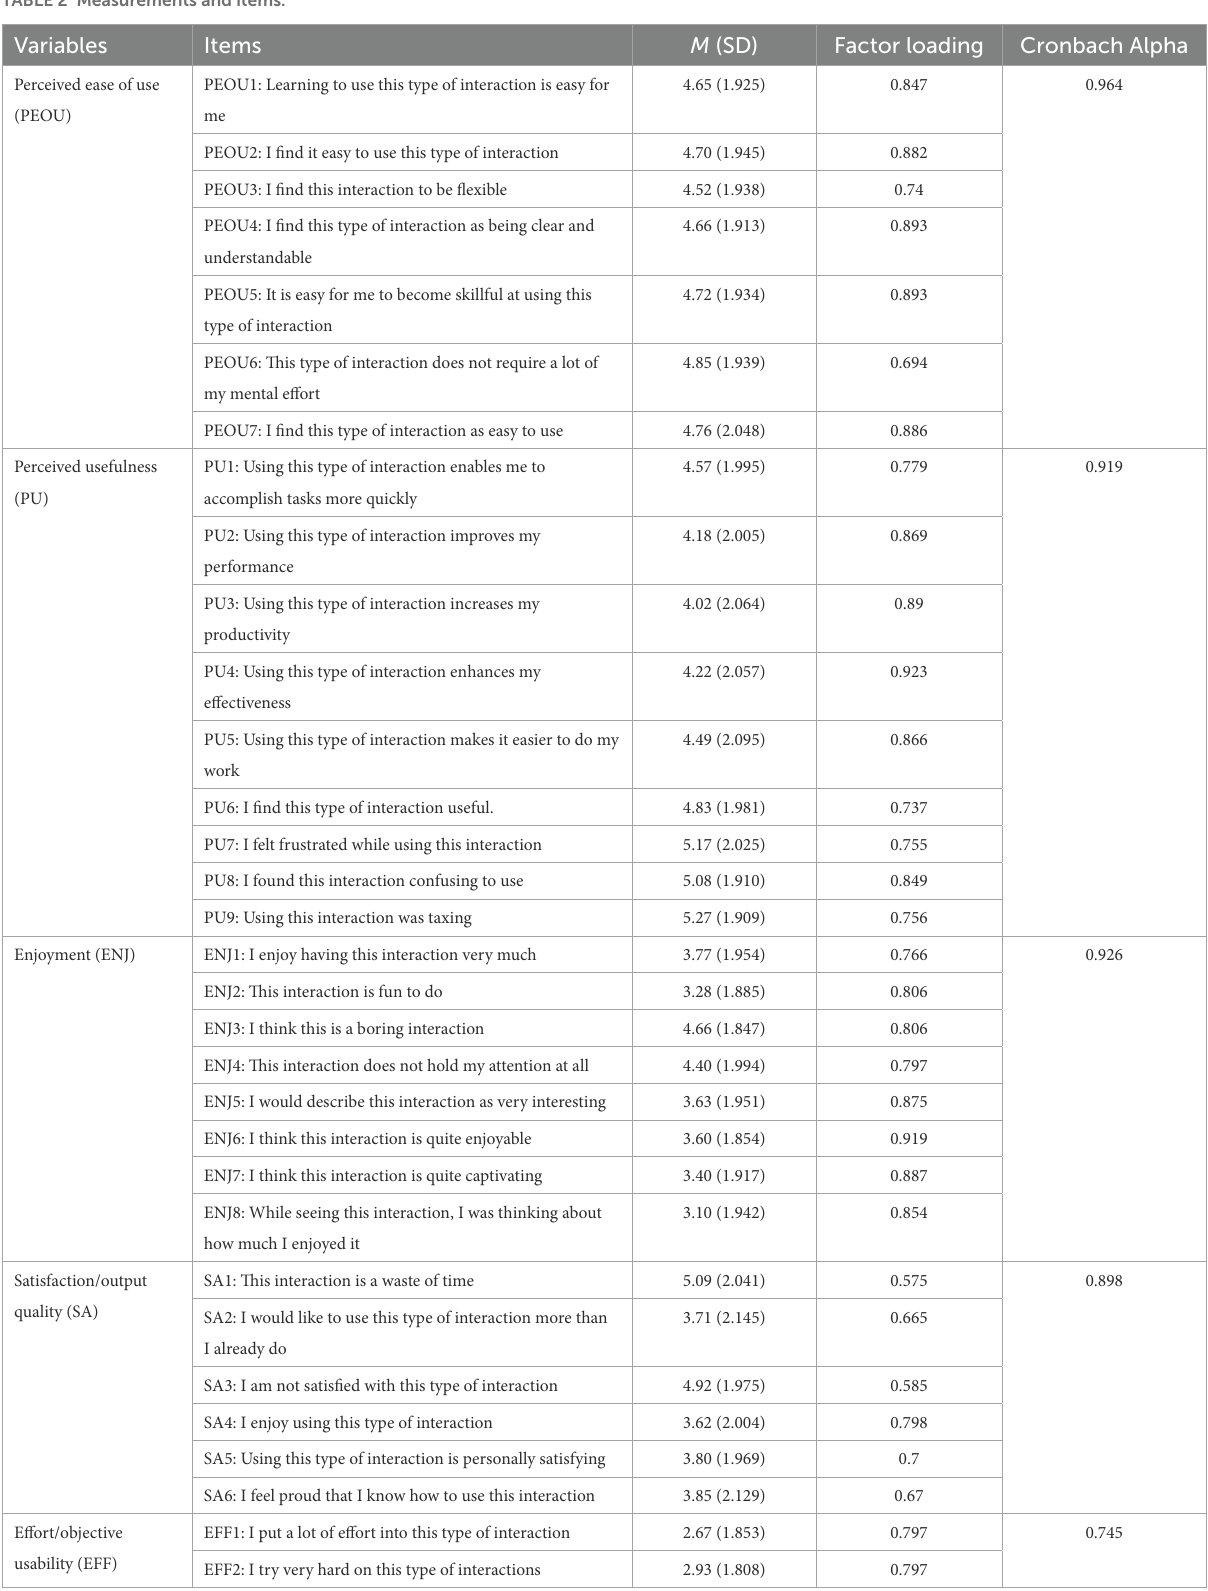
TABLE 2 Measurements and